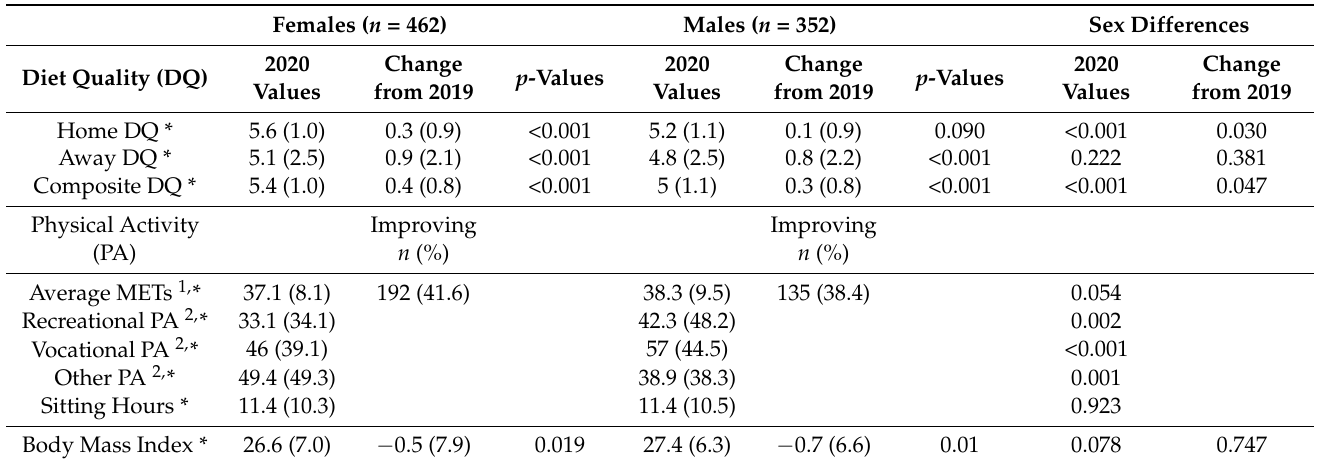
Table 2. Diet quality, physical activity and body mass index of US men and women in June 2019 and